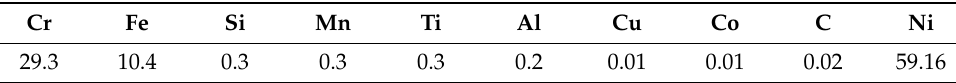
Table 2. Chemical composition of Alloy 690TT tubes